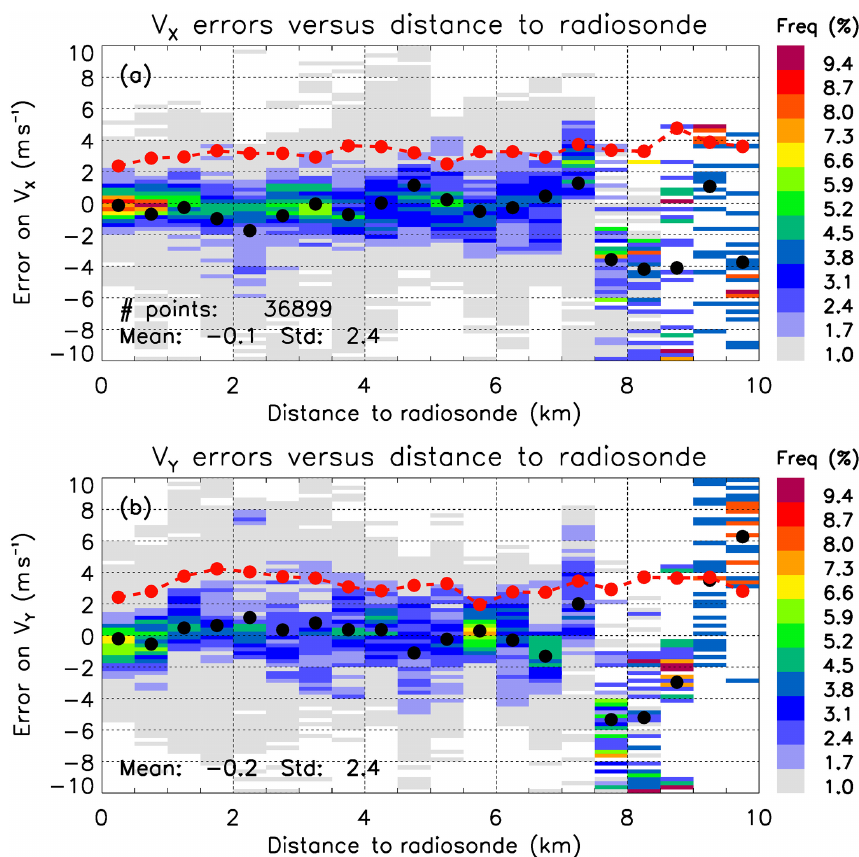
Figure 8. Frequency distribution of (a) eastward and (northward) wind component errors as a function of the horizontal distance between the ship and the balloon. The sign convention is (retrieved-radiosonde) wind. The frequency is normalized to 100% for each distance bin. Black dots and red dots are the estimates of the bias and standard deviation of the error for each bin, respectively. The mean bias and standard of the error for the first bin is given on each panel. The total number of points is given in panel (a) .